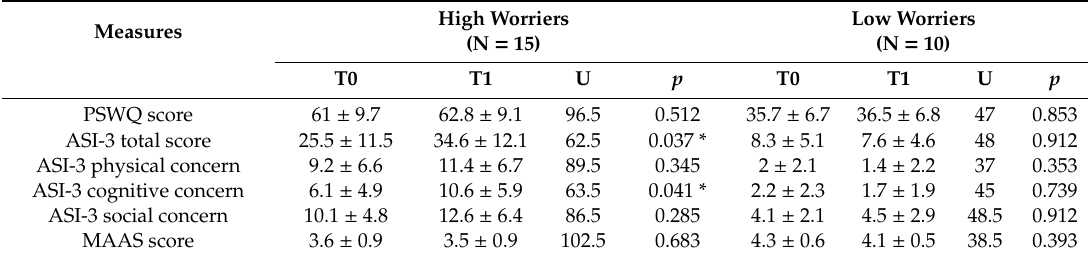
lockdown, separately in high and low worriers.